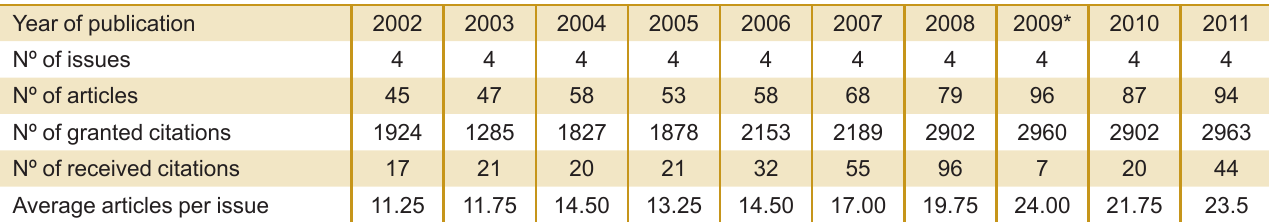
TABLE I - Numerical Data - SciELO Basis - Content and